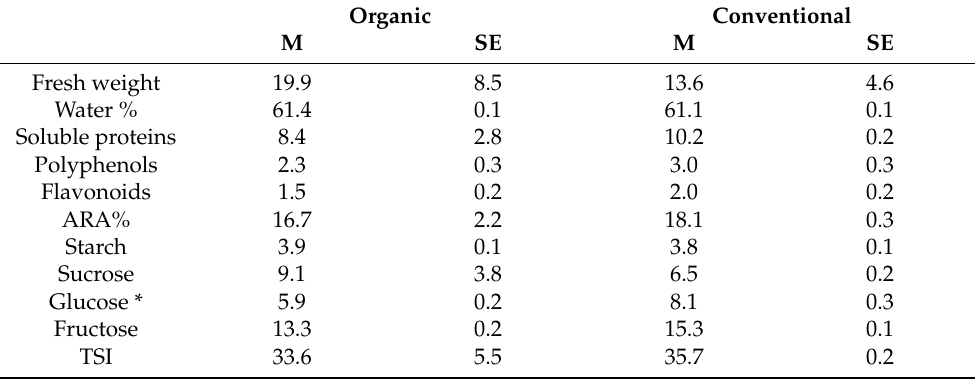
Table 3. Nutraceutical parameters measured in elephant garlic bulbs cultivated organically and conventionally in Valdichiana. All values not in % are in mg/g fw, except the fresh weight of the cloves which is in grams. TSI = total sweetness index. * = statistically significant ( p < 0.05)